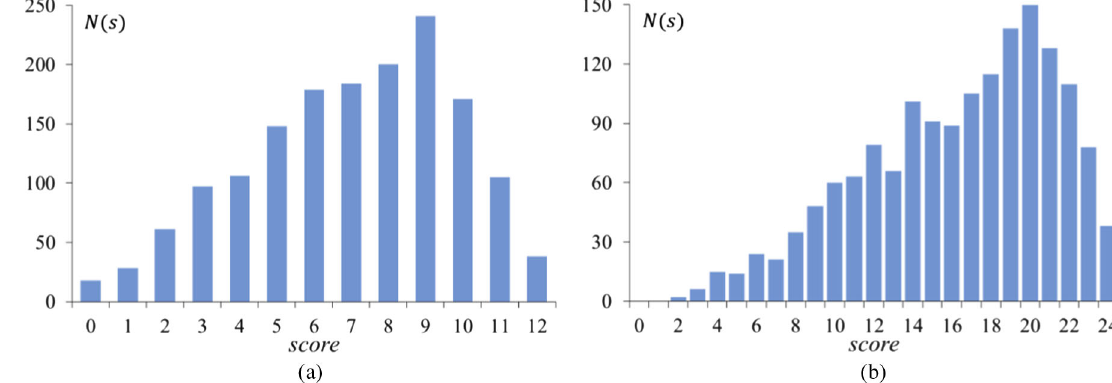
FIG. 1. Score distribution: (a) pair scoring method and (b) individual scoring